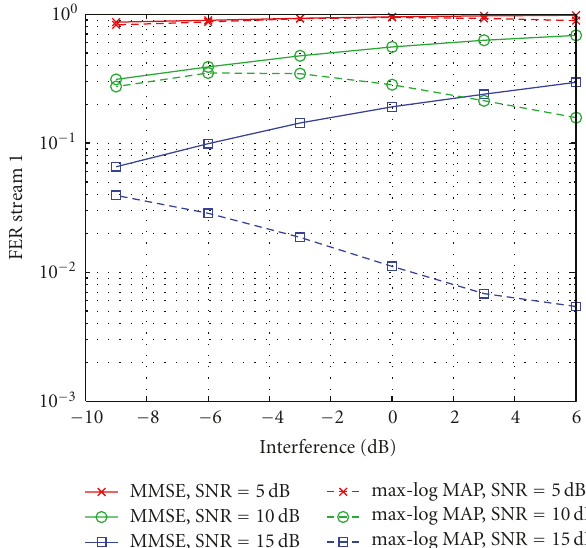
Figure 9: Frame error rate of the first stream of the of the MMSE and max-log MAP receiver for a frequency flat Rayleigh fading channel. Results are plotted for di ff erent SNR levels of the first stream. The x -axis denotes the interference of the second stream w.r.t. the first stream.